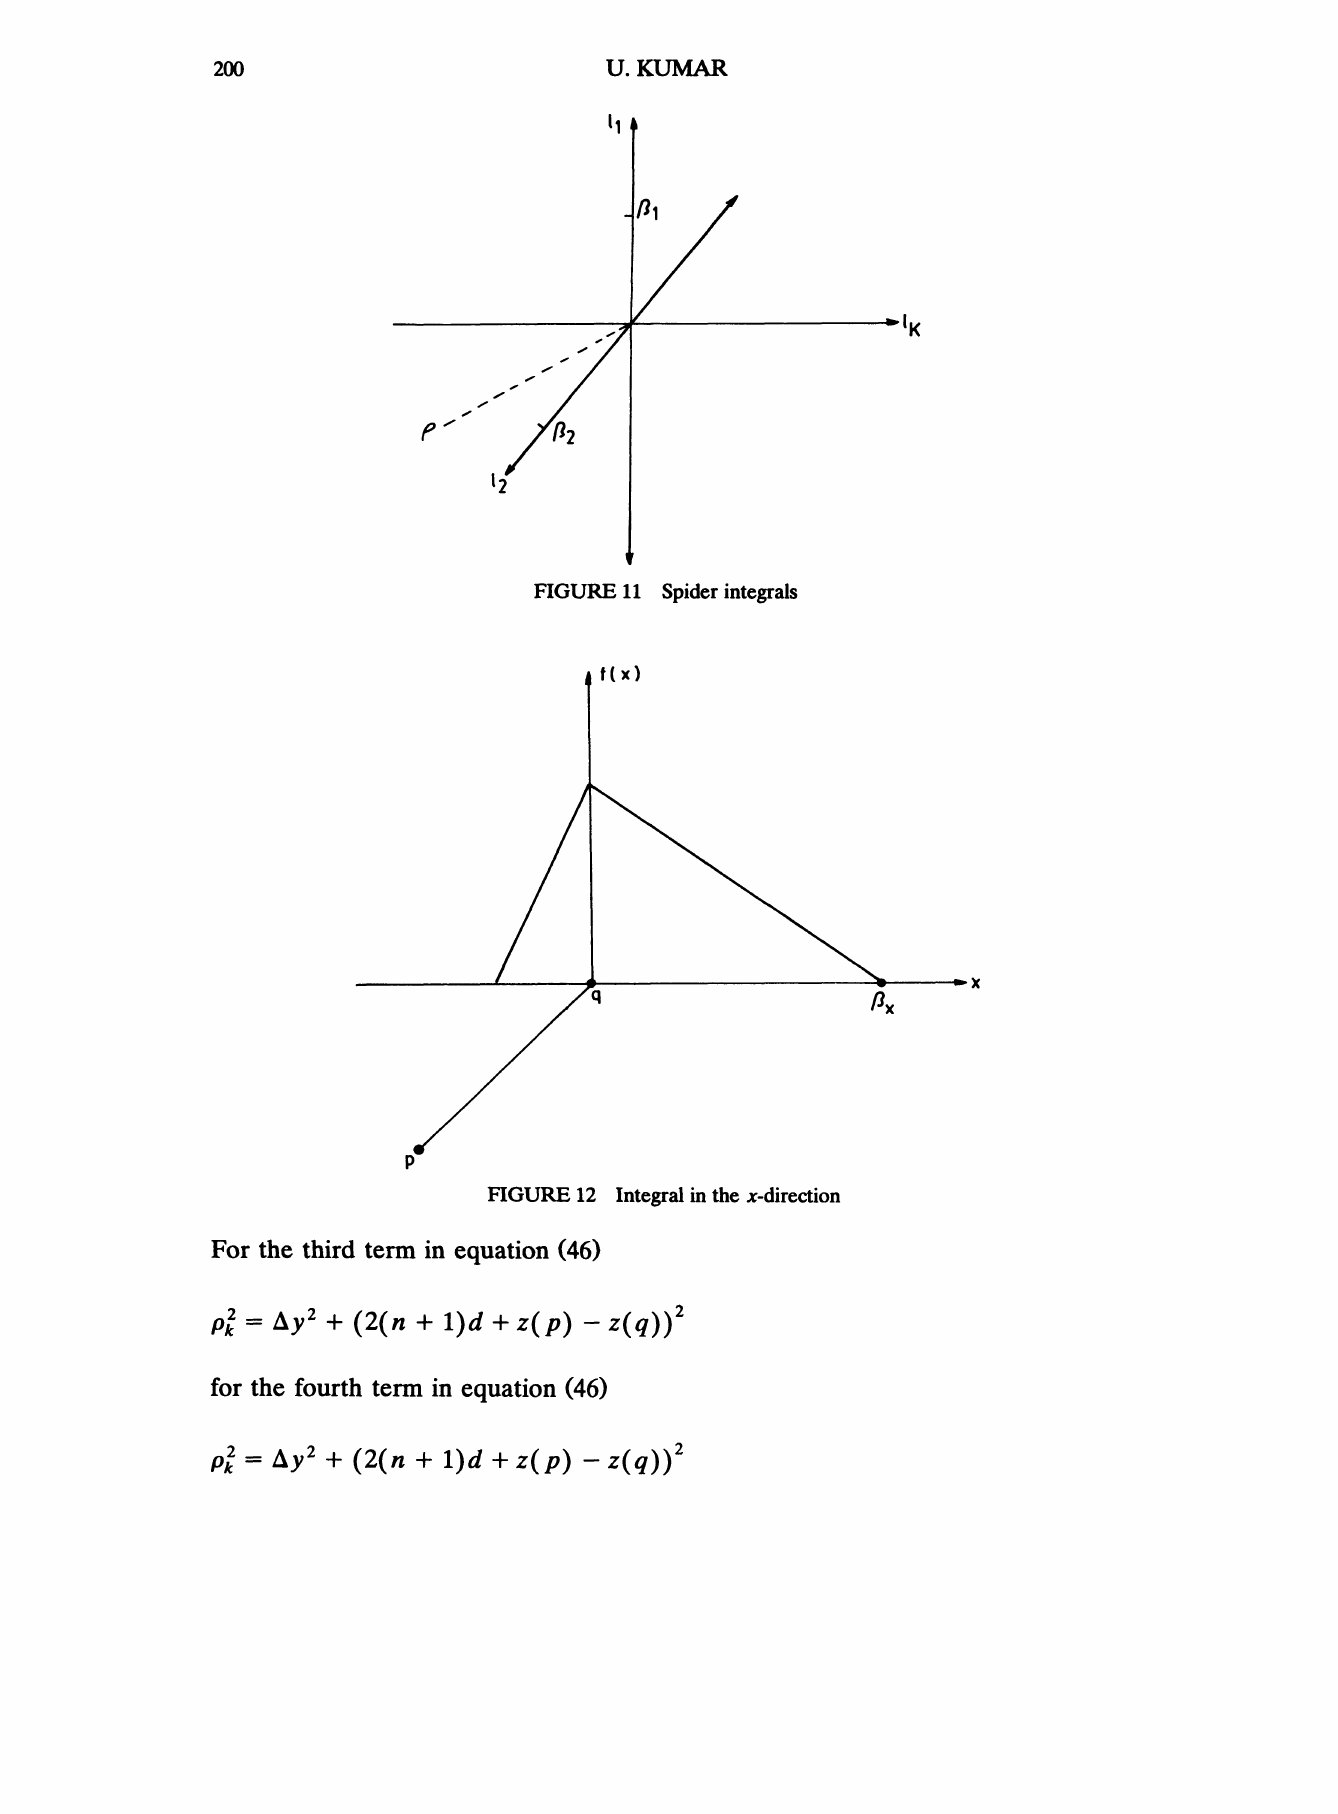
FIGURE 11 Spider integrals